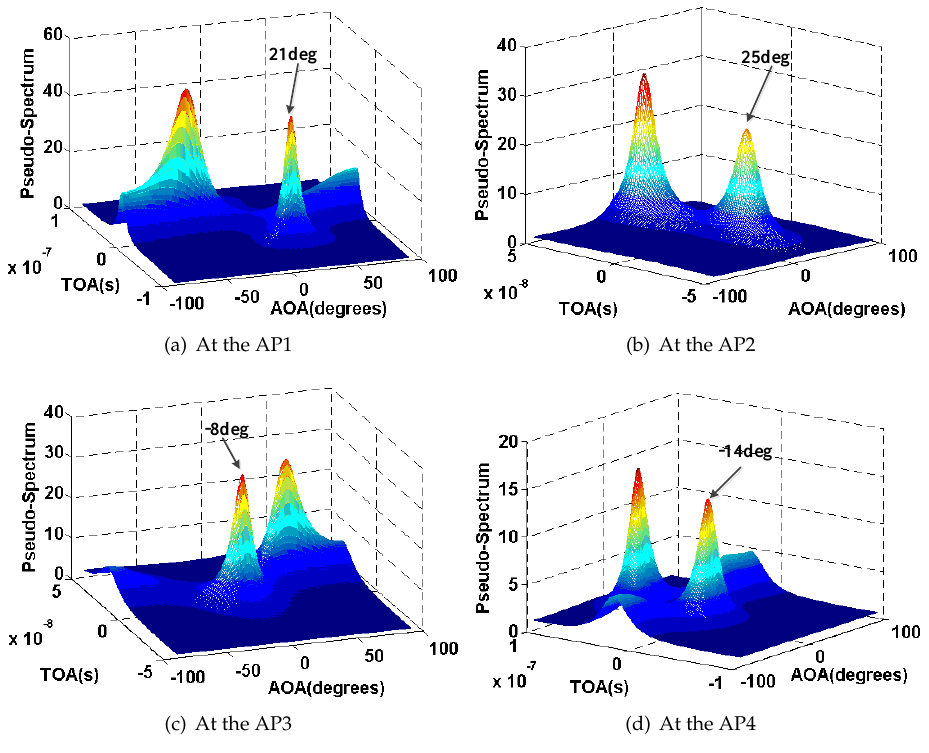
Figure 13. Results of AOA and TOA estimation.